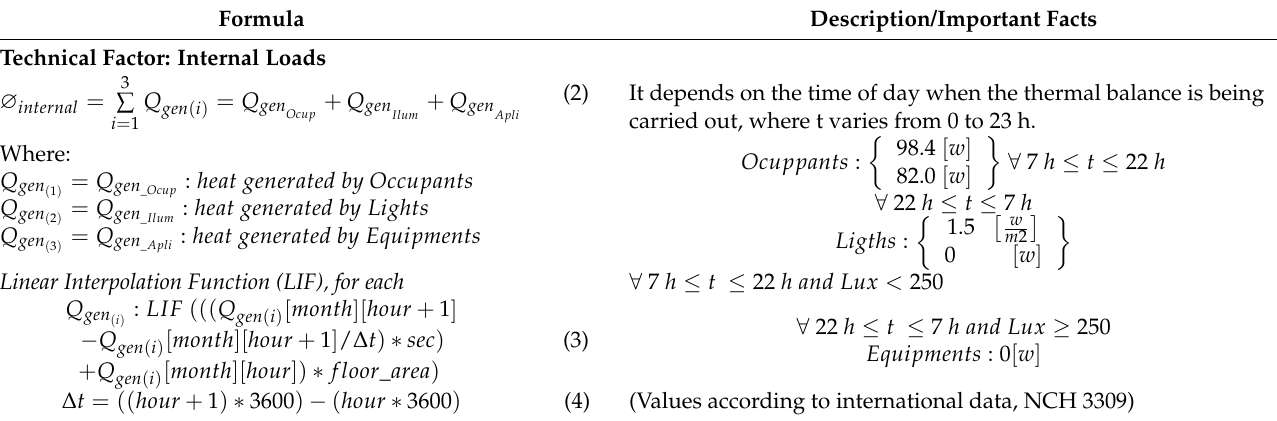
Table 3. Housing Energy Rating (CEV) system factors and